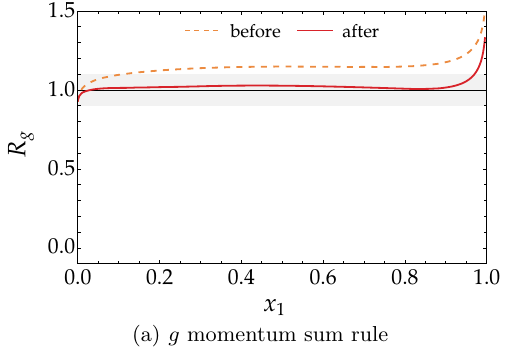
Fig. 10 Change of the sum rule ratio (38) due to the modification of the g → d ¯ d splitting at large y . The sum rule is exactly satisfied if ˜ R = 0 dd v